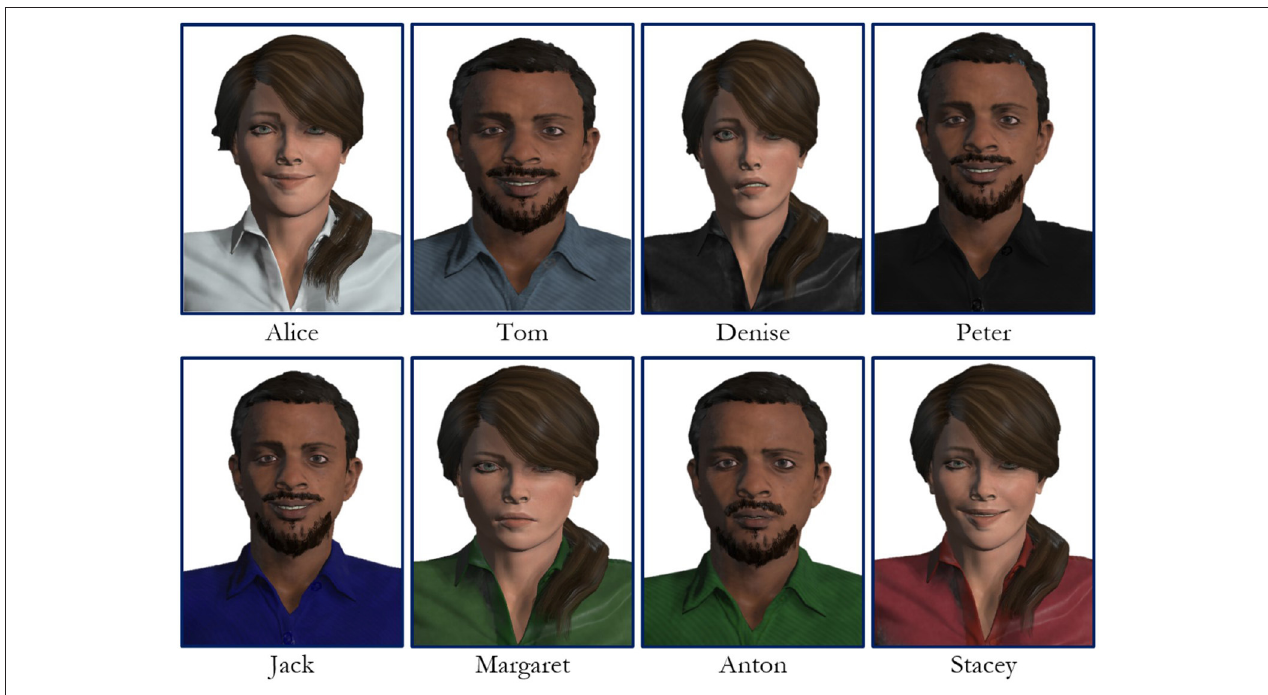
FIGURE 3 | VHs developed using Adobe Fuse